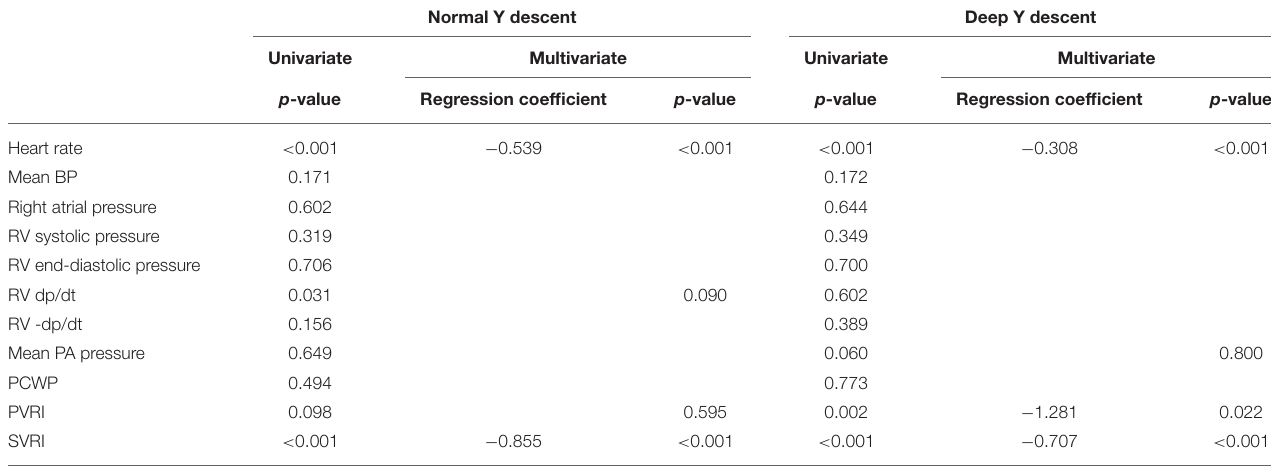
TABLE 3 | The relationship between SVI and other measurements available from right heart